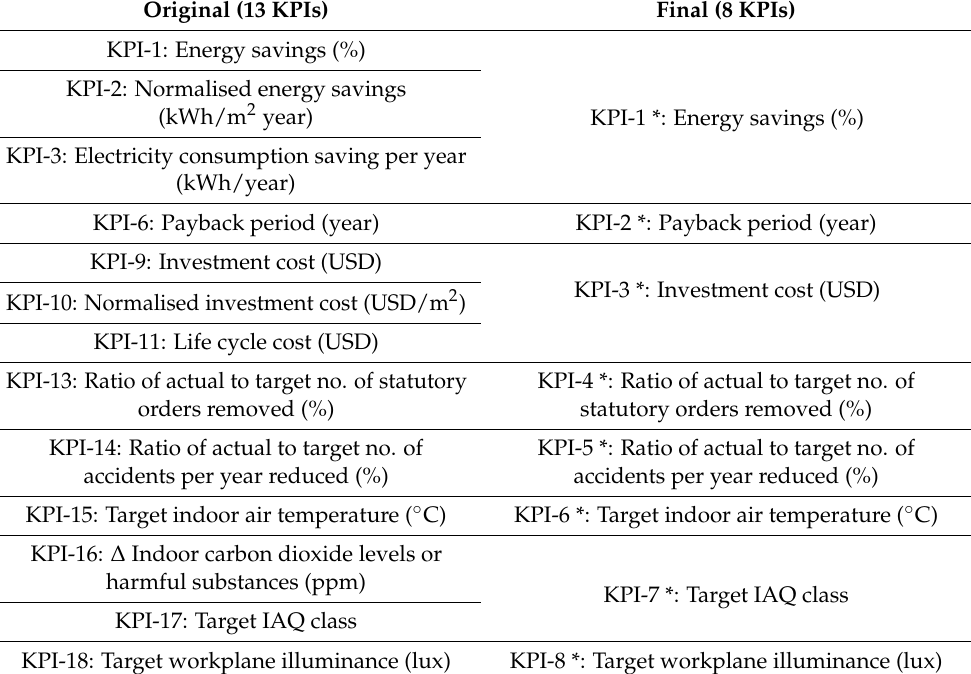
Table 6. Original and final KPIs.